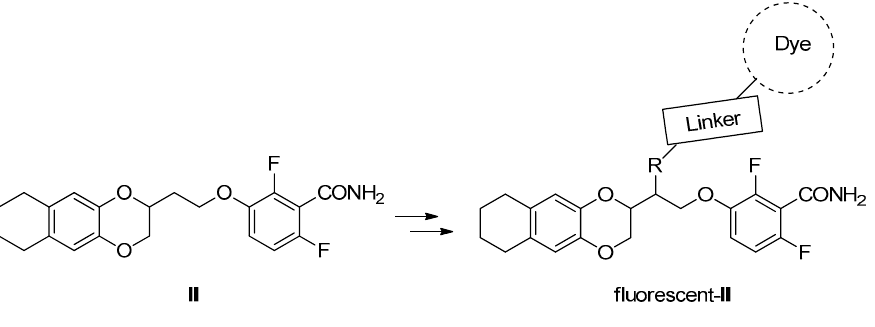
Figure 2. Structures of II and of the desired fluorescent analogue.